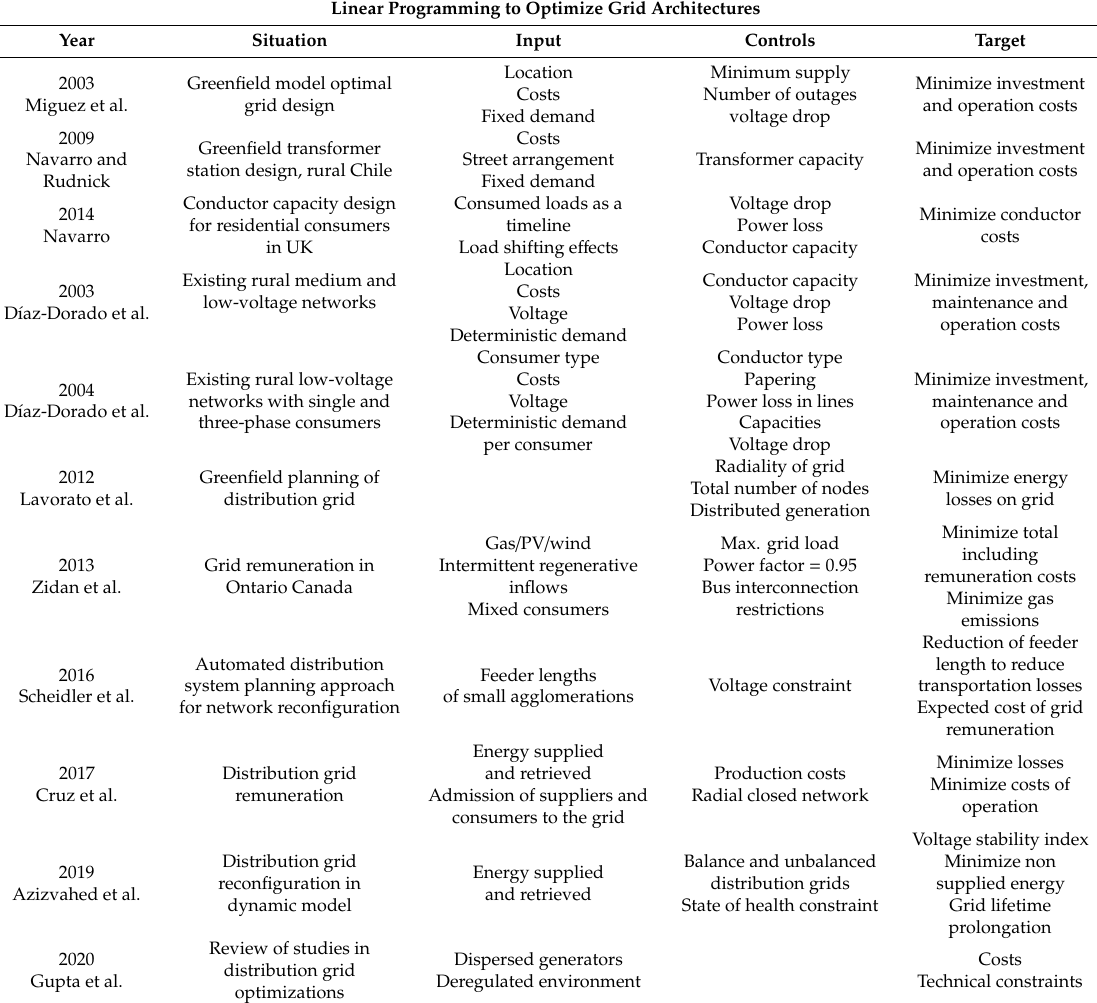
Table 2. Summary of previous studies using linear programming for grid